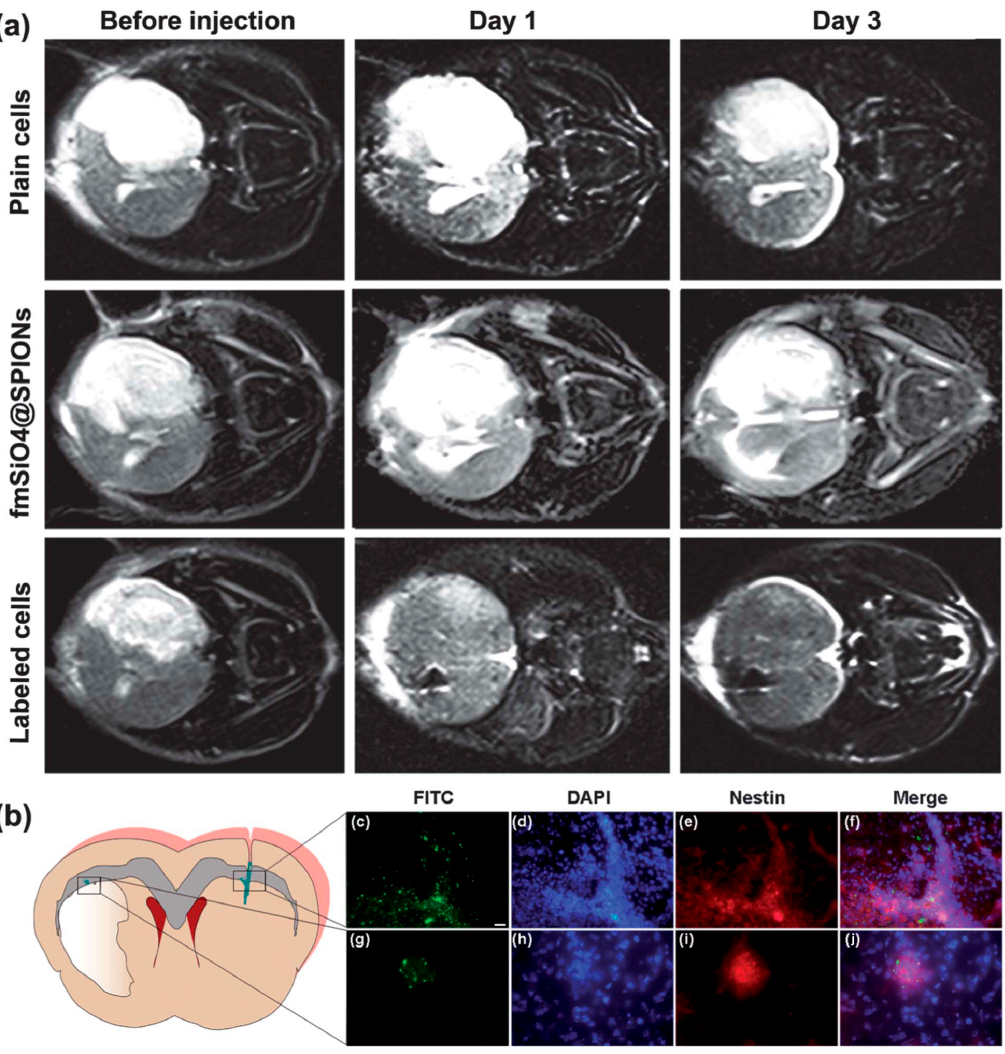
Figure 12. MRI tracking of fmSiO 4 @SPION-labeled C17.2 cells infused intracerebrally, contralateral to